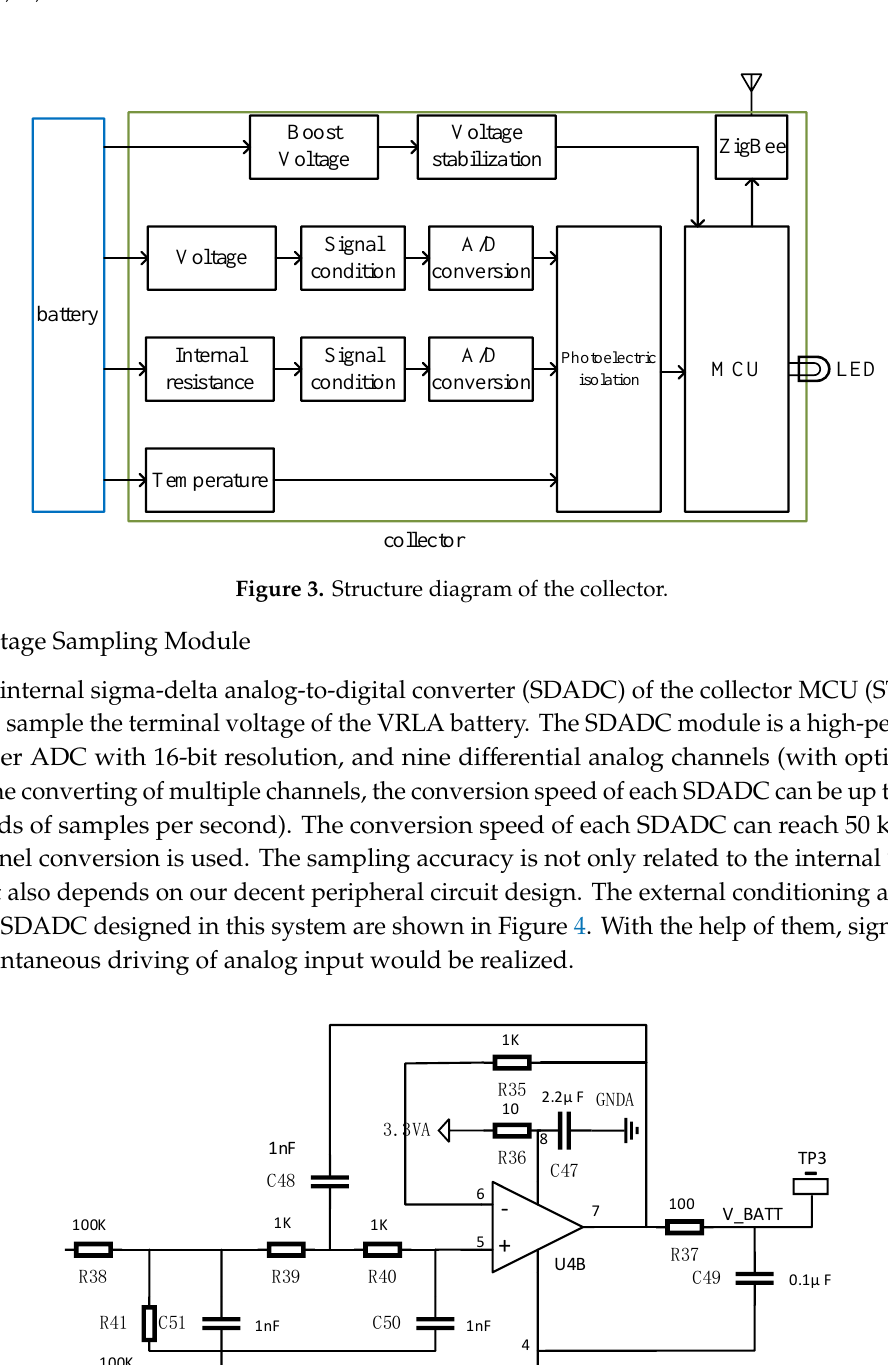
Figure 4. External conditioning and driving circuit of SDADC.